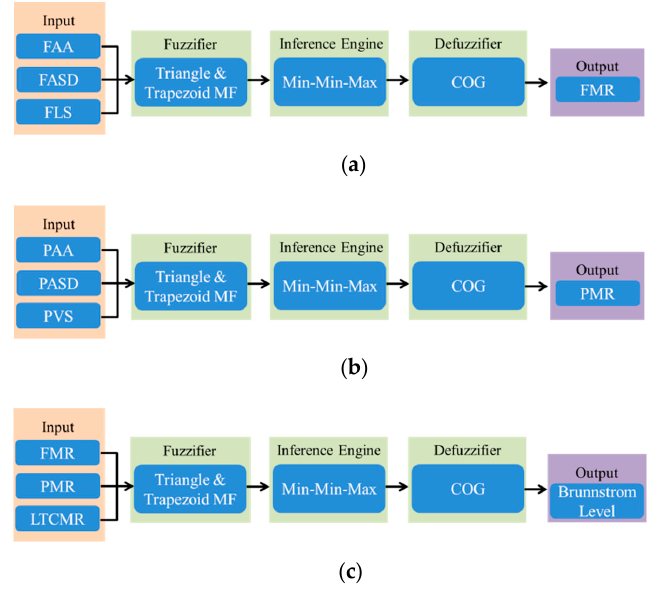
Figure 8. Schematic diagram of Fuzzy inference ( a ) Flexion ( b ) Pronation, and ( c ) Brunnstrom